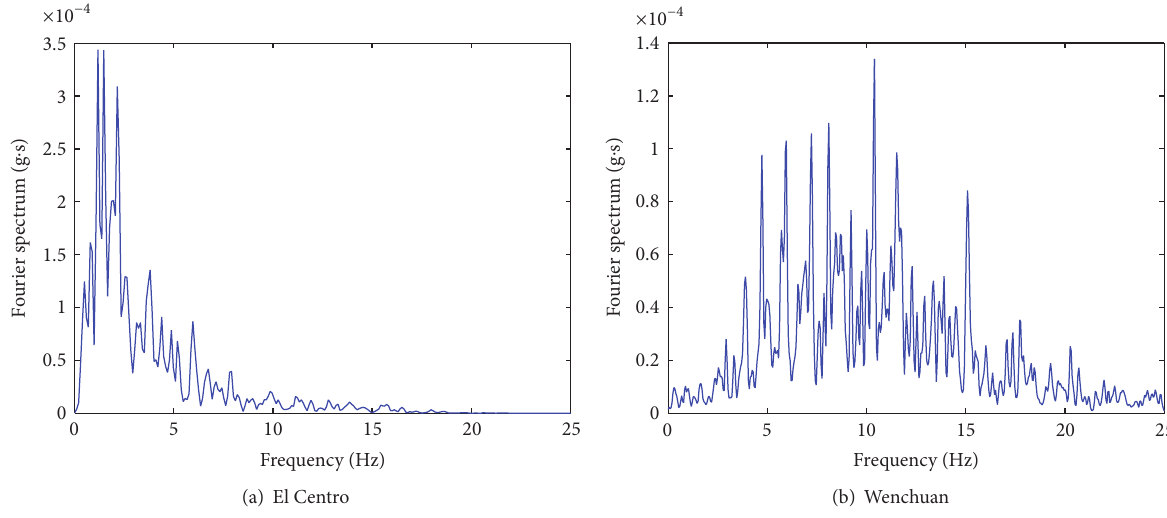
Figure 16: Flourier spectrum of the seismic wave used in the